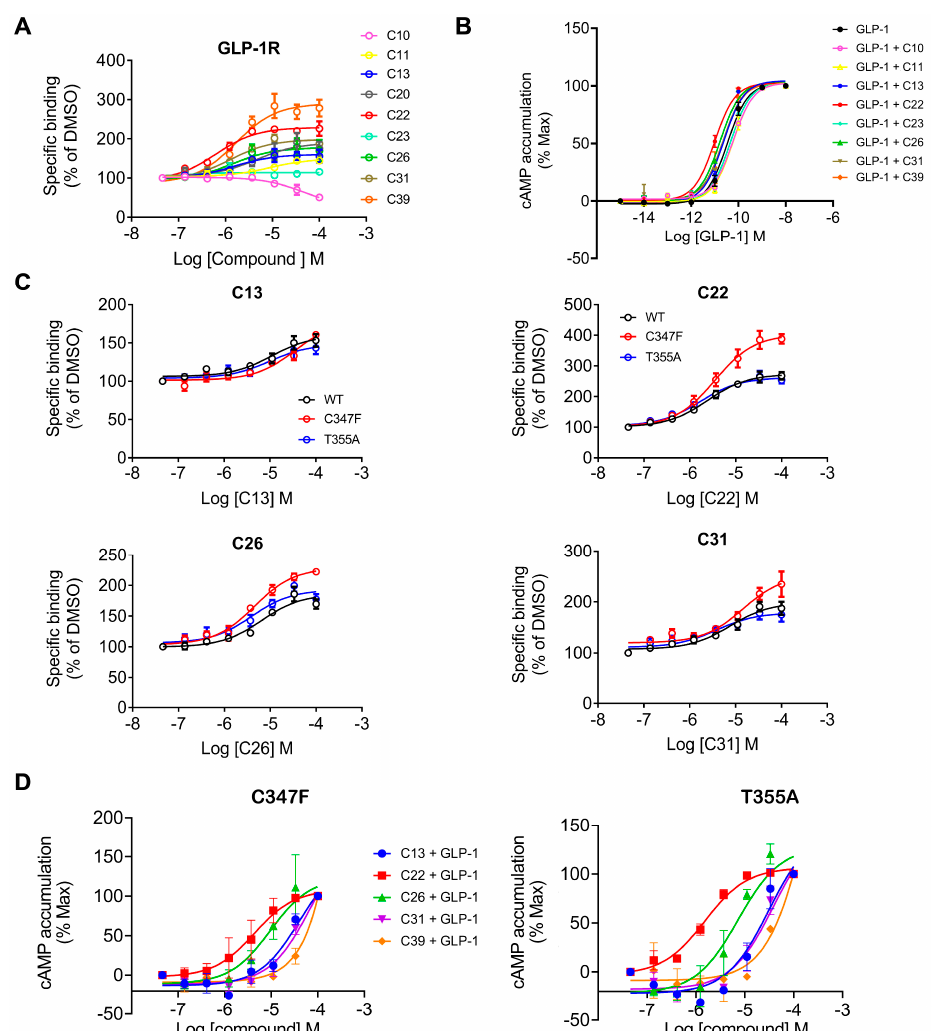
Figure 6. Experimental validation of selected compounds identified using LBVS on GLP-1R. ( A ) Binding of hit compounds to GLP-1R or its mutants in competition with radiolabeled GLP-1. ( B ) cAMP activity induced by different GLP-1 concentrations in the presence of hit compounds (20 μ M) in GLP-1R expressing CHO-K1 cells. ( C ) Binding of four hit compounds to GLP-1R mutants (C347F and T355A) in competition with radiolabeled GLP-1. ( D ) Effects of binding-pocket mutations (C347F and T355A) on the allosteric modulation of selected compounds in cAMP accumulation elicited by 0.02 nM GLP-1. Data are presented as means ± S.E.M. of three independent experiments.